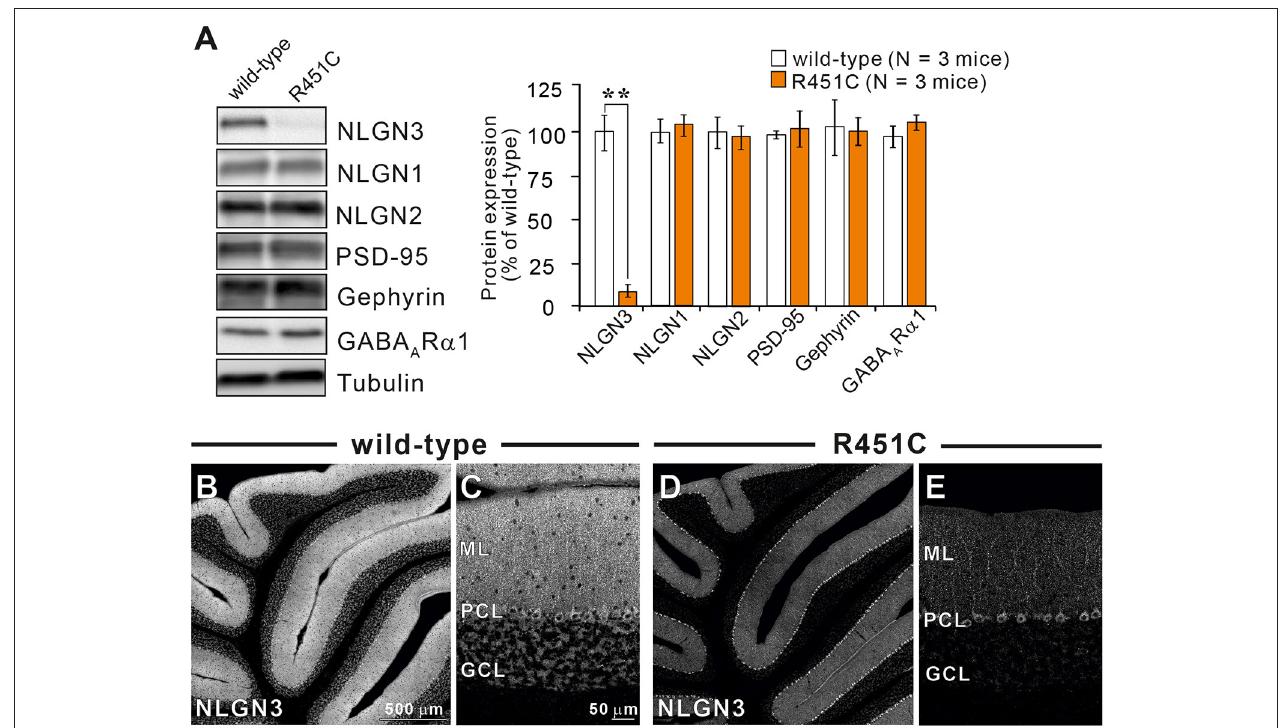
FIGURE 3 | The NLGN3-R451C mutation greatly reduces the expression of NLGN3 but not other synaptic proteins in the cerebellum. (A) Representative immunoblots (left panel) and summary bar graphs (right panel) showing the expression levels of several synaptic proteins in cerebellar homogenates from 2-month-old wild-type (open columns) and age-matched NLGN3-R451C mutant mice (orange columns) ( N = 3 mice/group). Representative synaptic proteins (NLGN1, neuroligin-1; NLGN2, neuroligin-2; NLGN3, neuroligin-3; PSD-95, Gephyrin, GABA A receptor subunit α 1) were analyzed by quantitative immunoblotting. Data are expressed as mean ± SD. ** p < 0.001 by Student’s t -test. (B–E) Immunohistochemistry for NLGN3 in the cerebellum with a low magnification (B,D) and with a high magnification (C,E) in 2-month-old wild-type (B,C) and age-matched NLGN3-R451C mutant (D,E) mice. ML, molecular layer; PCL, Purkinje cell layer; GCL, granule cell layer. In wild-type mice, NLGN3 signal is intense in ML and GL, whereas that in NLGN3-R451C mutant mice is decreased. Scales bars represent 500 µ m for (B,D) , and 50 µ m for (C,E) .